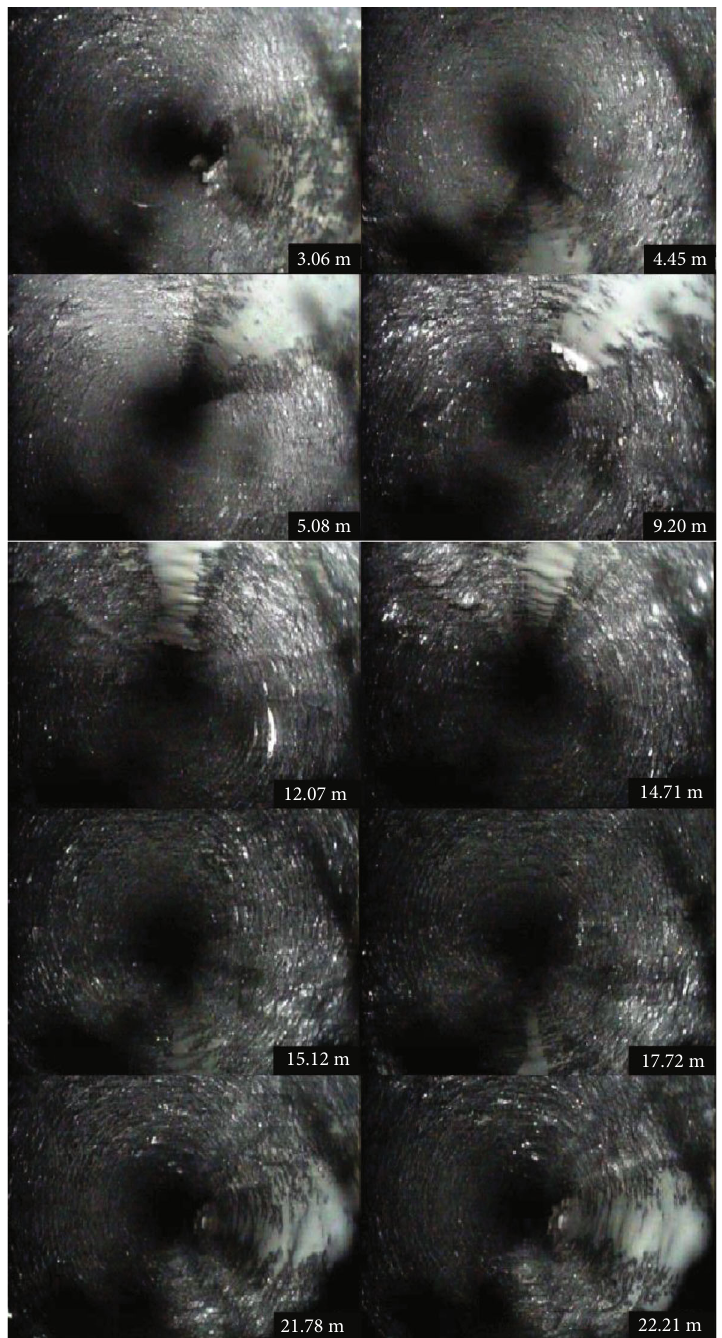
Figure 6: View of gas drainage borehole in C 5b coal